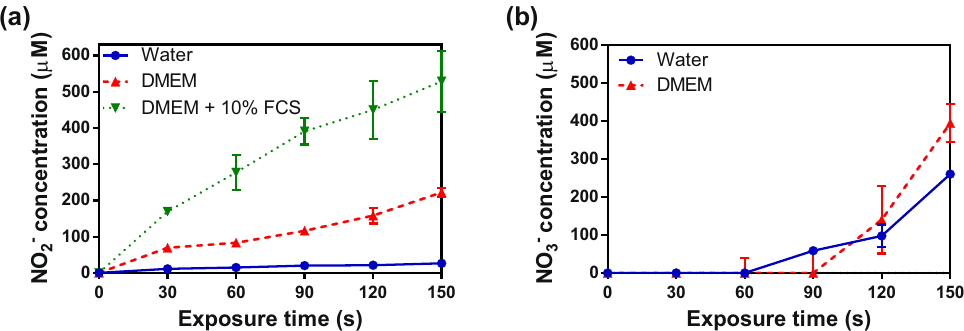
Figure 10. Variation of the concentration of ( a ) Nitrite anion and ( b ) Nitrate anion concentration in water, DMEM + / − 10% FCS after He plasma treatment at various exposure